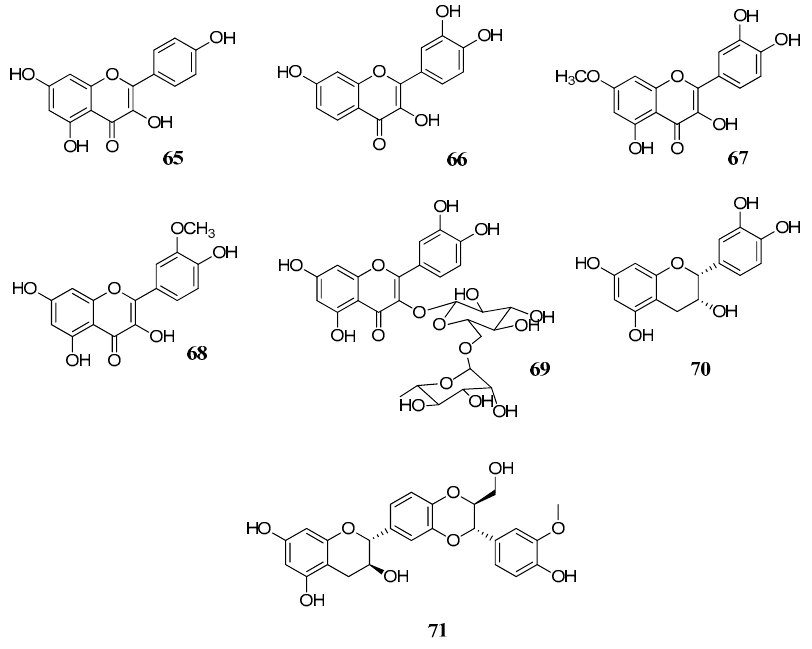
Figure 15. Structures of compounds 65 – 71 [46,67].